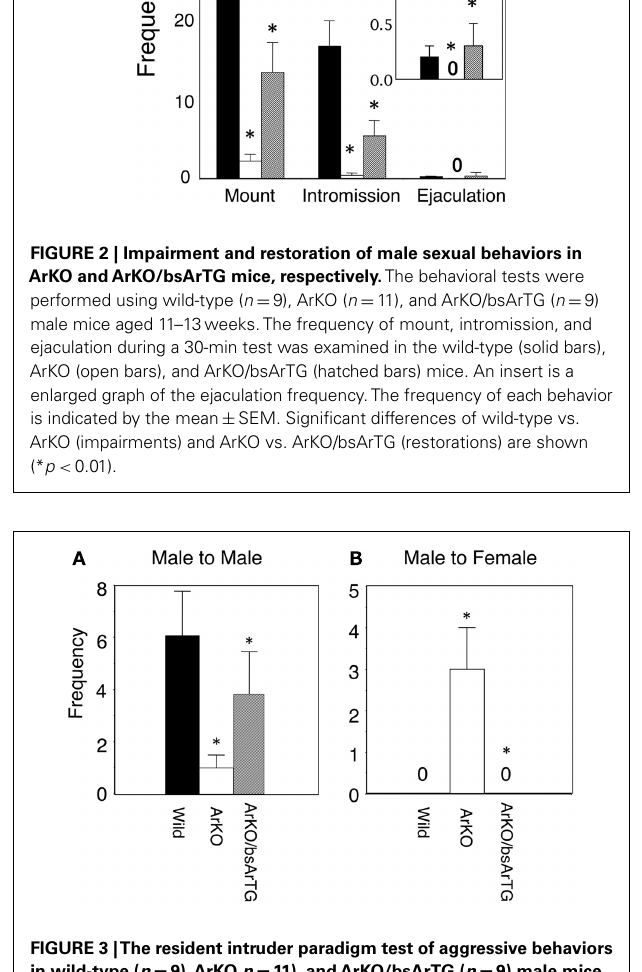
FIGURE 3 |The resident intruder paradigm test of aggressive behaviors in wild-type ( n = 9),ArKO n = 11), andArKO/bsArTG ( n = 9) male mice aged 12–14weeks. The test male was examined in his home cage as the resident against a group-housed olfactory-bulbectomized male intruder (A) or an estrous female (B) .The frequency of each aggressive behavior is indicated by the mean ± SEM. Significant differences of wild-type vs. ArKO and ArKO vs. ArKO/bsArTG are shown (* p < 0.01).